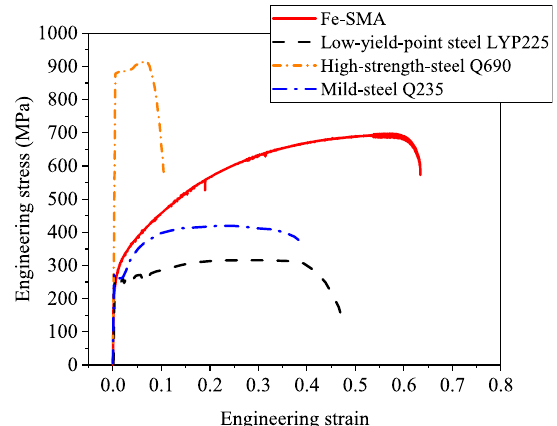
Fig. 2 Monotonic engineering stress–strain curves for Fe‑SMA and some typical structural steels